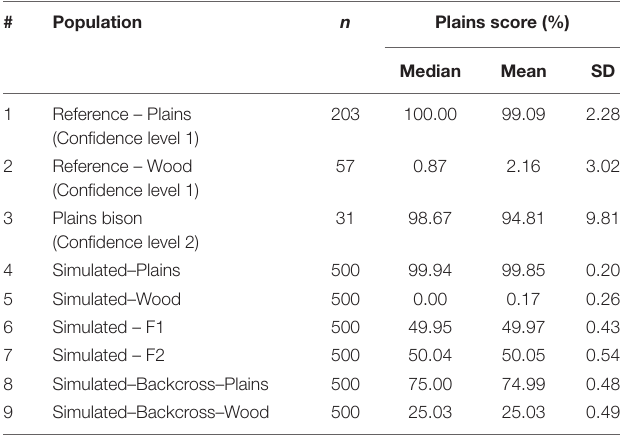
TABLE 3 | Estimated subspecies composition for reference population and simulated